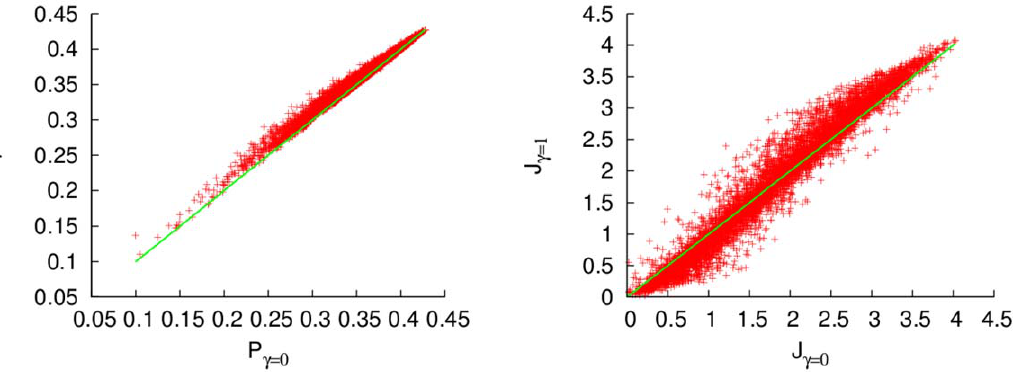
Figure 4. Excitation (left) and energy (right) fluxes for random uniformly distributed Hamiltonians in the low-temperature regime ( n ~ 100 ), for a dephasing ratio c ~ 1 , as functions of the fluxes without dephasing. The green line separates the configurations with enhancement and depression of the transfer. Units of cm { 1 .